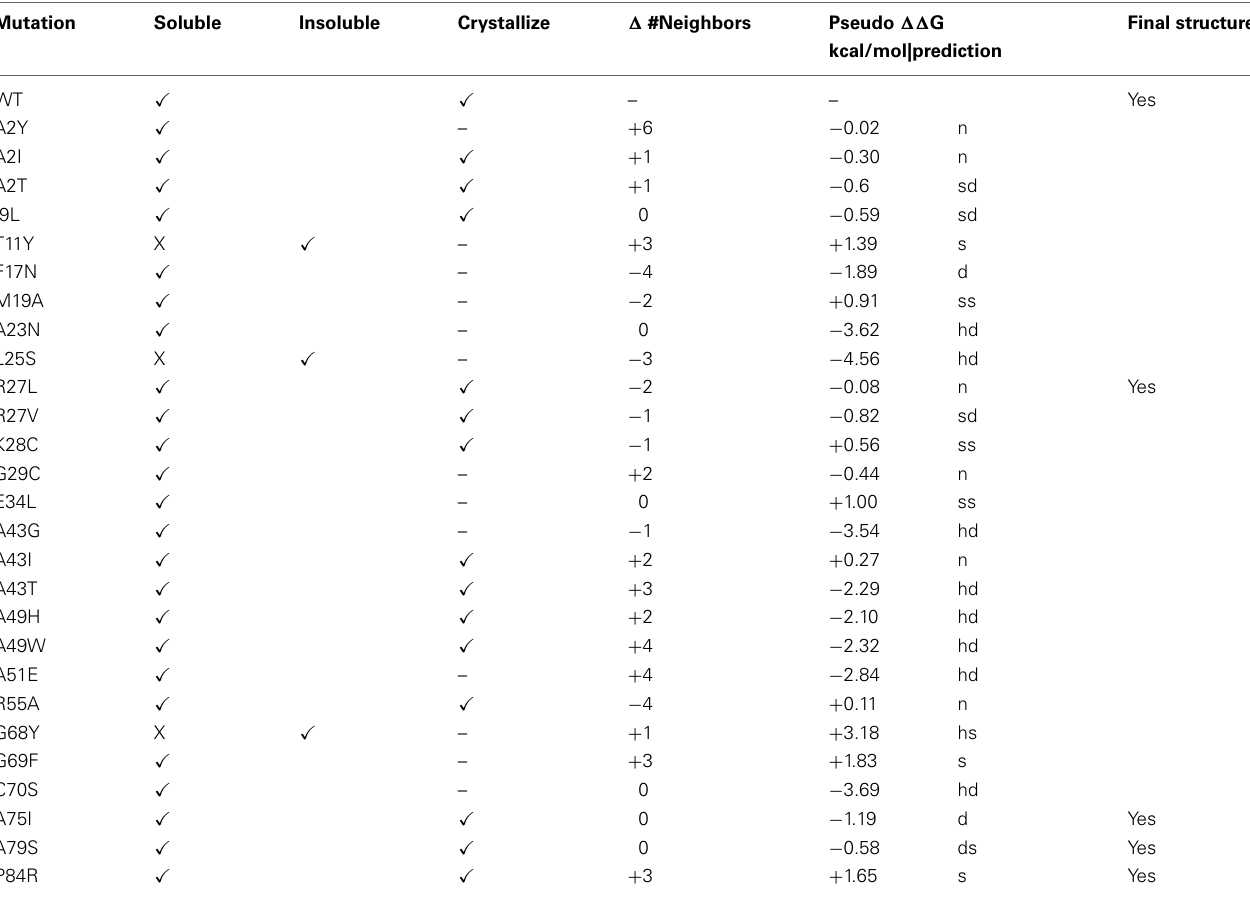
Table 1 | List of currently studied mutations in Synechocystis sp. PCC 6803 glutaredoxin A. Mutation